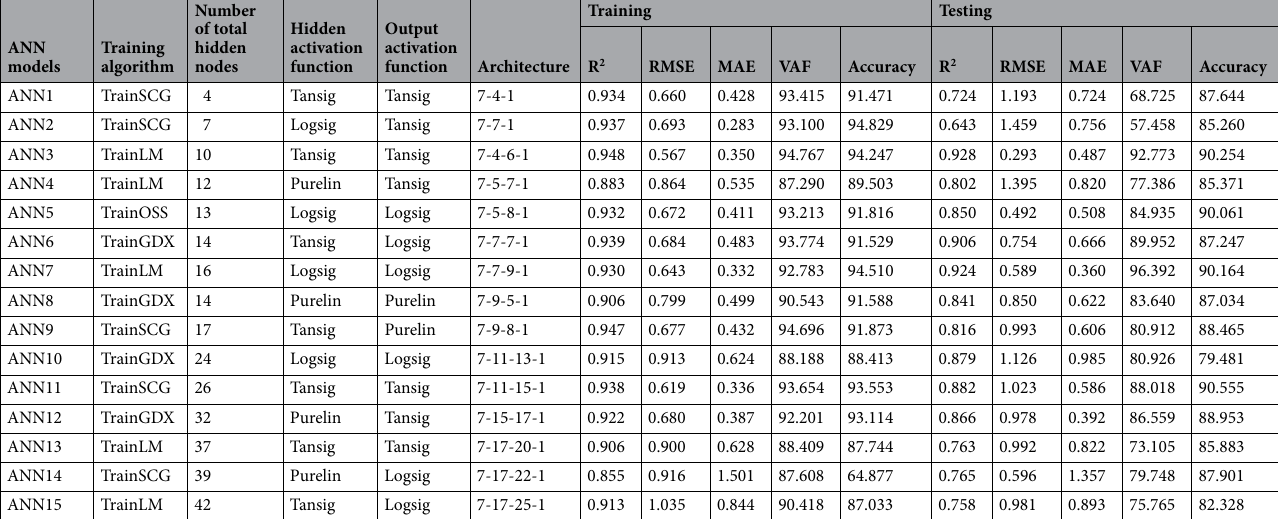
Table 4. The base models of ANN and their evaluations. LM Levenberg–Marquardt, GDX Adaptive learning rate, SCG Scaled conjugate gradient, OSS One-step